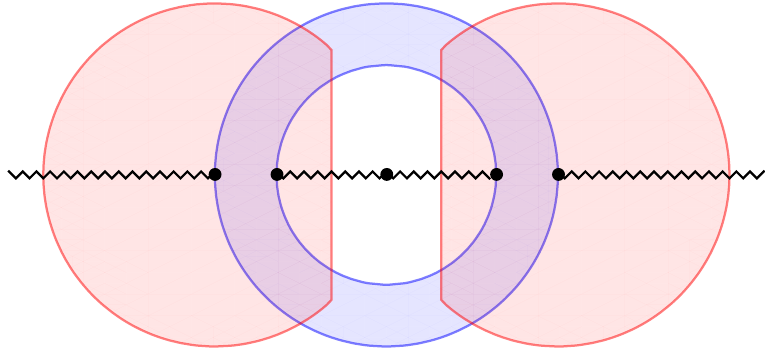
Figure 4. For (cid:12)xed r 2 (0 ; 1), the s -channel OPE (expansion around z = (cid:22) z = 0) implies that the thermal two-point function g ( z; (cid:22) z ) is analytic in an annulus in the w plane between radii r and 1 =r (shaded blue). The t -channel OPE (expansion around z = (cid:22) z = 1), together with symmetry under w $ (cid:0) w , implies analyticity in the red-shaded regions, except for cuts running along ( (cid:0)1 ; (cid:0) 1 =r ) ; ( (cid:0) r; 0) ; (0 ; r ) ; (1 =r; 1 ) (indicated with zig-zags). In this section, we argue for analyticity everywhere in the upper and lower half